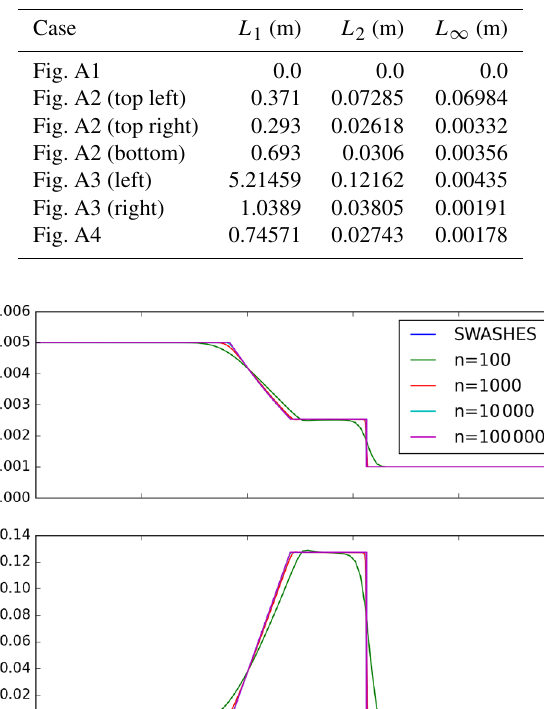
Table A1. Analytical steady flows: summary of L norms for errors in water depth; L norms for errors in unit discharge are in the range of machine accuracy and are omitted here.